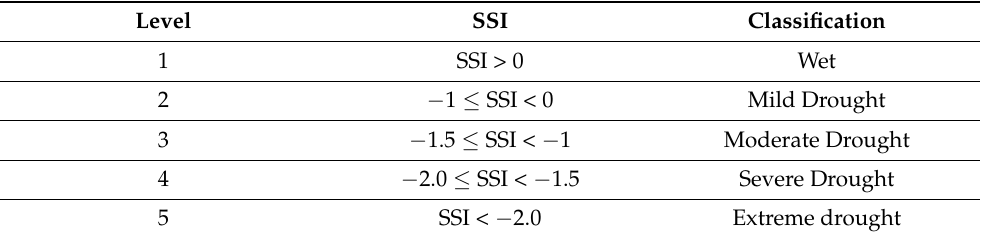
Table 2. SSI Classification